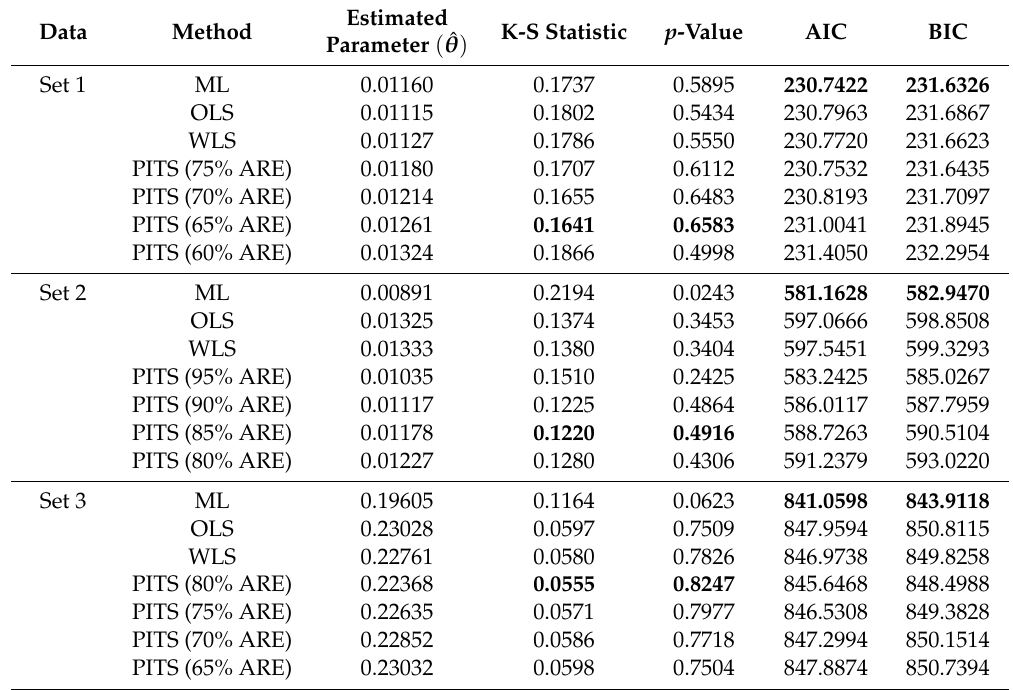
Table 10. Parameter estimates and goodness of fits of the Lindley distributions of data Sets 1, 2, 3 and